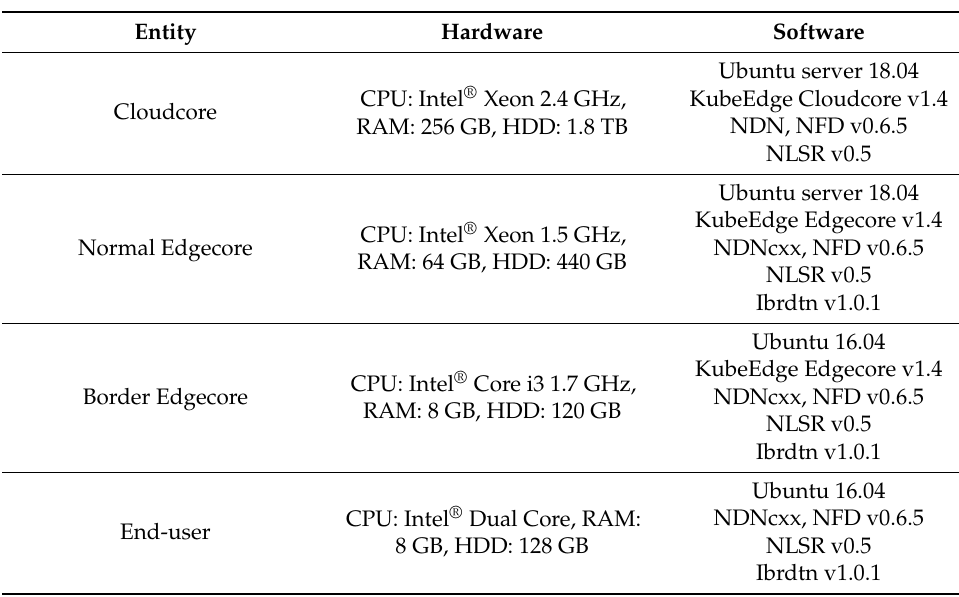
Figure 9. Cross-regional NDN network topology in the implementation. Table 2. Detailed implementation configuration.